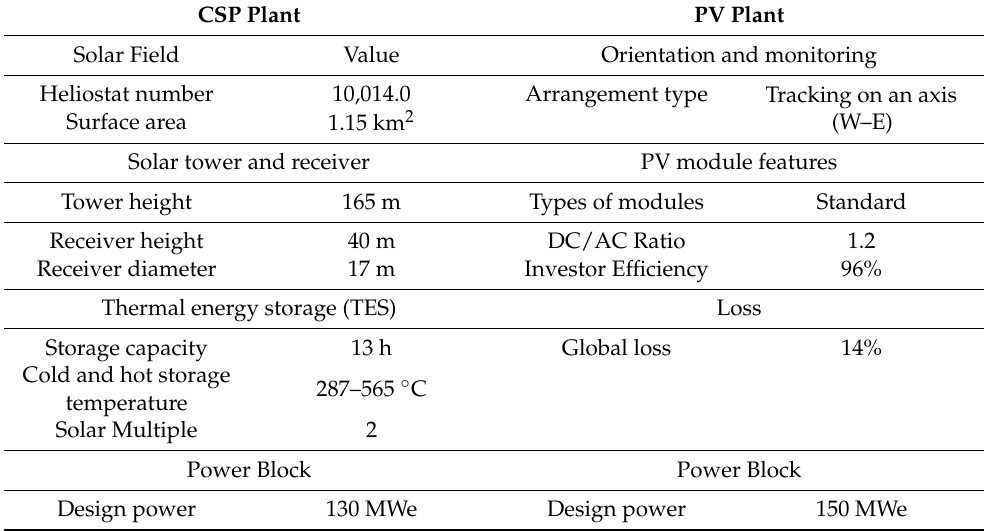
Table 6. Input design parameters for PV and STP plant